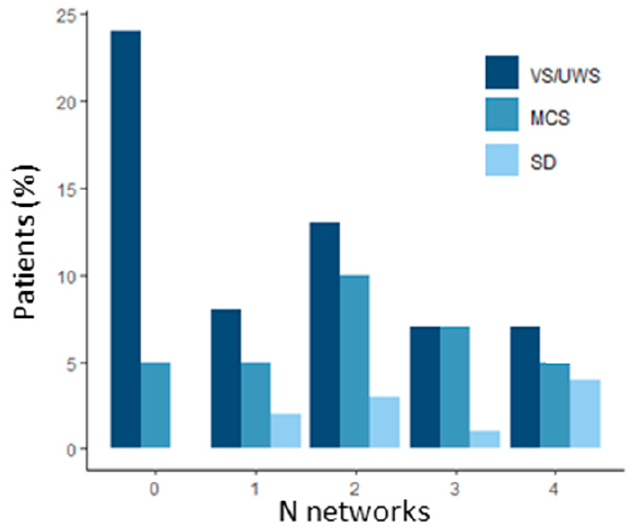
Figure 1. Percentage of patients having 0, 1, 2, 3 or 4 networks for each diagnostic group. Network detection was defined as a score ≥ 2 on at least one node of ICA or SBA maps for LVIS, MVIS, and AUD networks, and defined as a score ≥ 2 on at least two nodes of ICA or SBA maps for the SM Network.